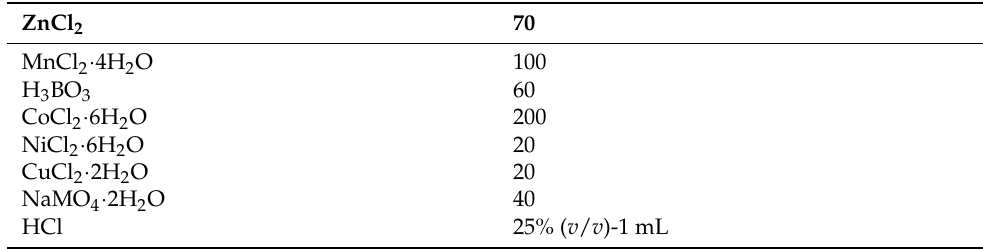
Table 6. Trace element composition for the enrichment